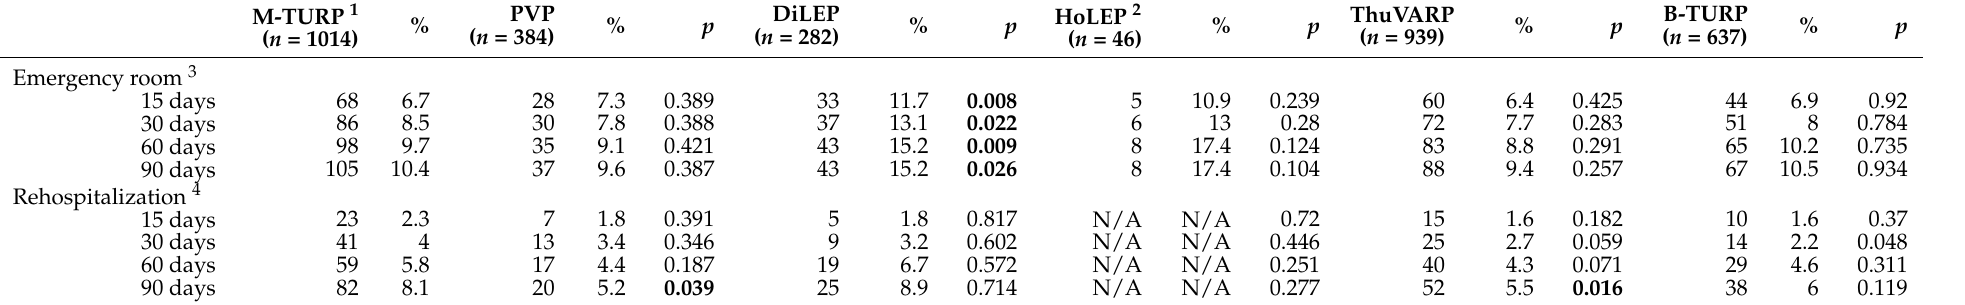
Table 3. Postoperative bleeding events in patients who underwent different LEPs or